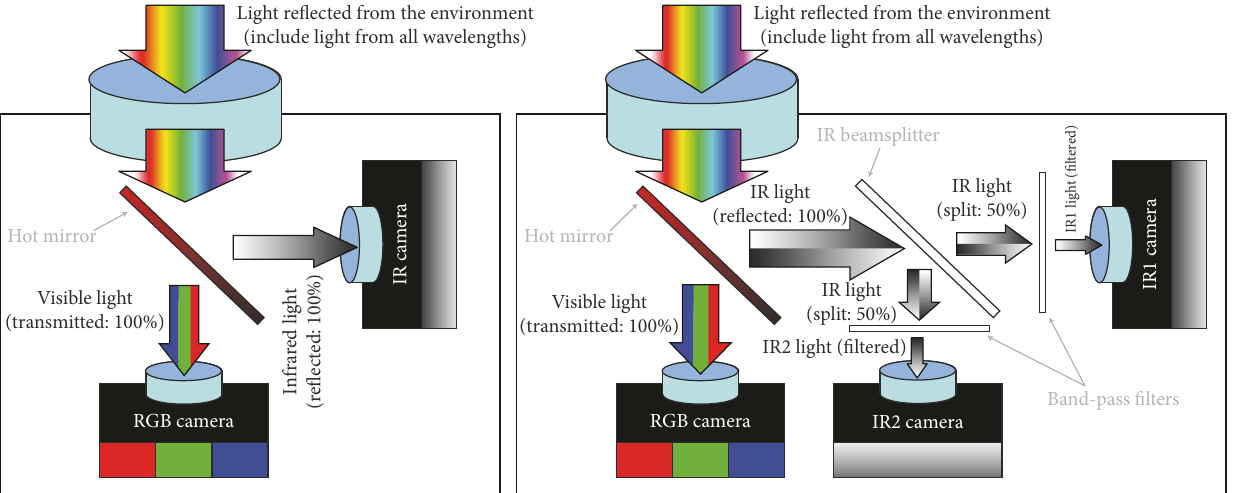
Figure3:Amultibandcamerawithasinglecameralens.Leftandrightimagesrepresentcameramechanismsregardingfour-andfive-channel projection mechanisms,